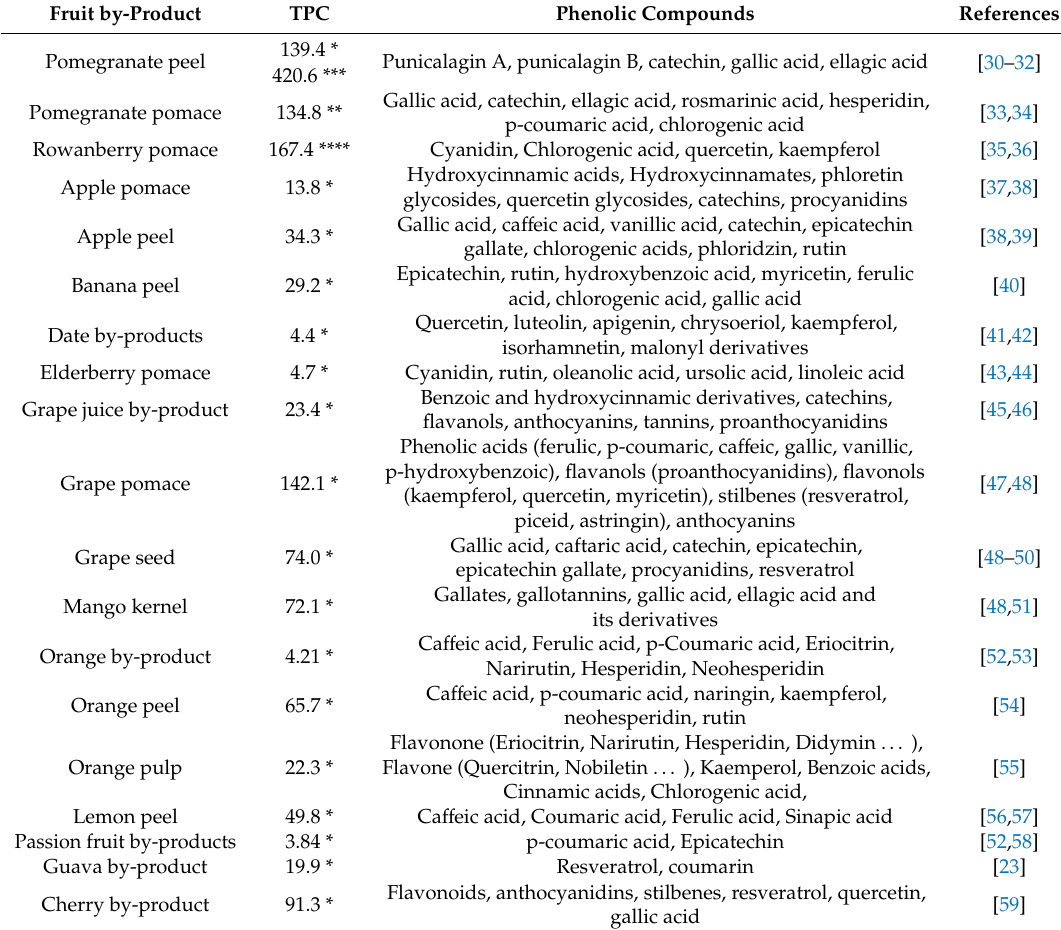
Table 1. Content of phenolic compounds in some fruit